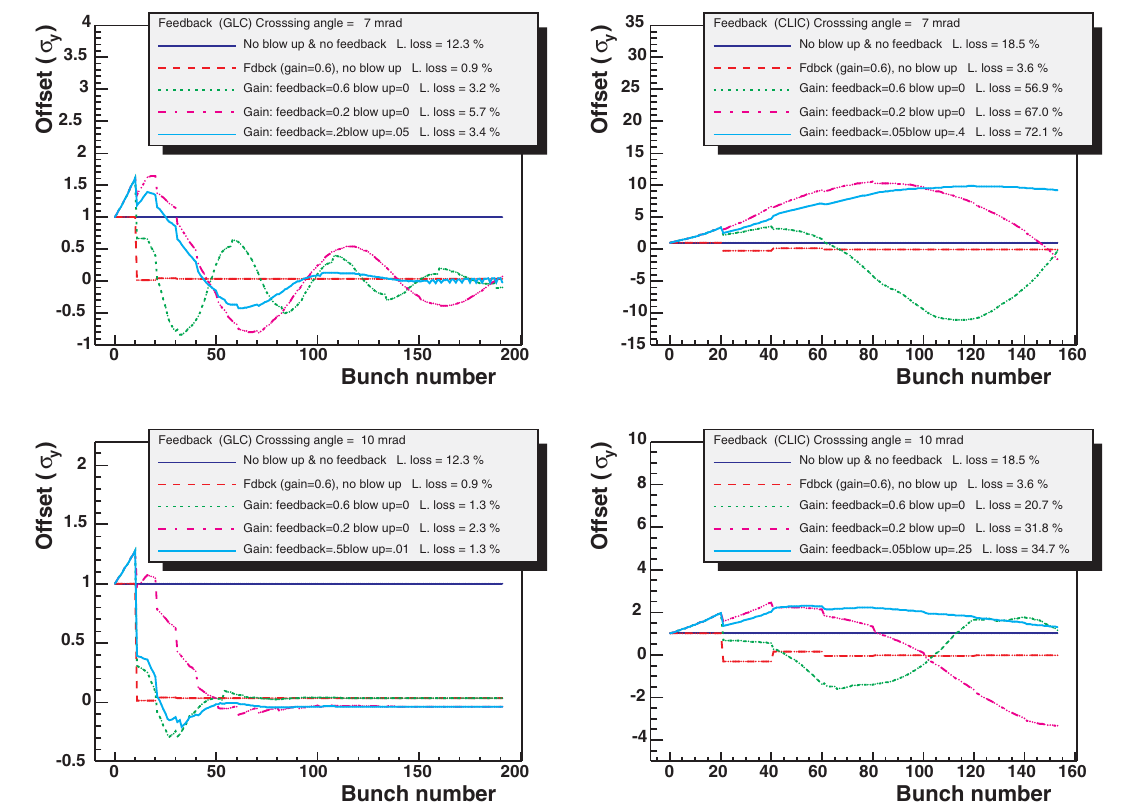
FIG. 10. (Color) Effect of the modified fast intrapulse feedback system on the beam blowup for different crossing angles for the GLC (left column) and CLIC (right column) for an initial beam offset of 1 (cid:1) quad. The fast feedback system used here has been modified as shown on Fig. 9.